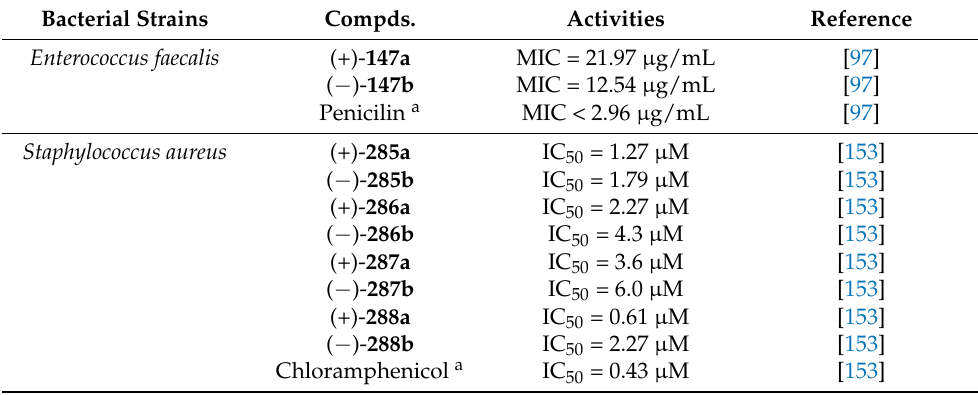
Table 4. Antibacterial activities of enantiomers.